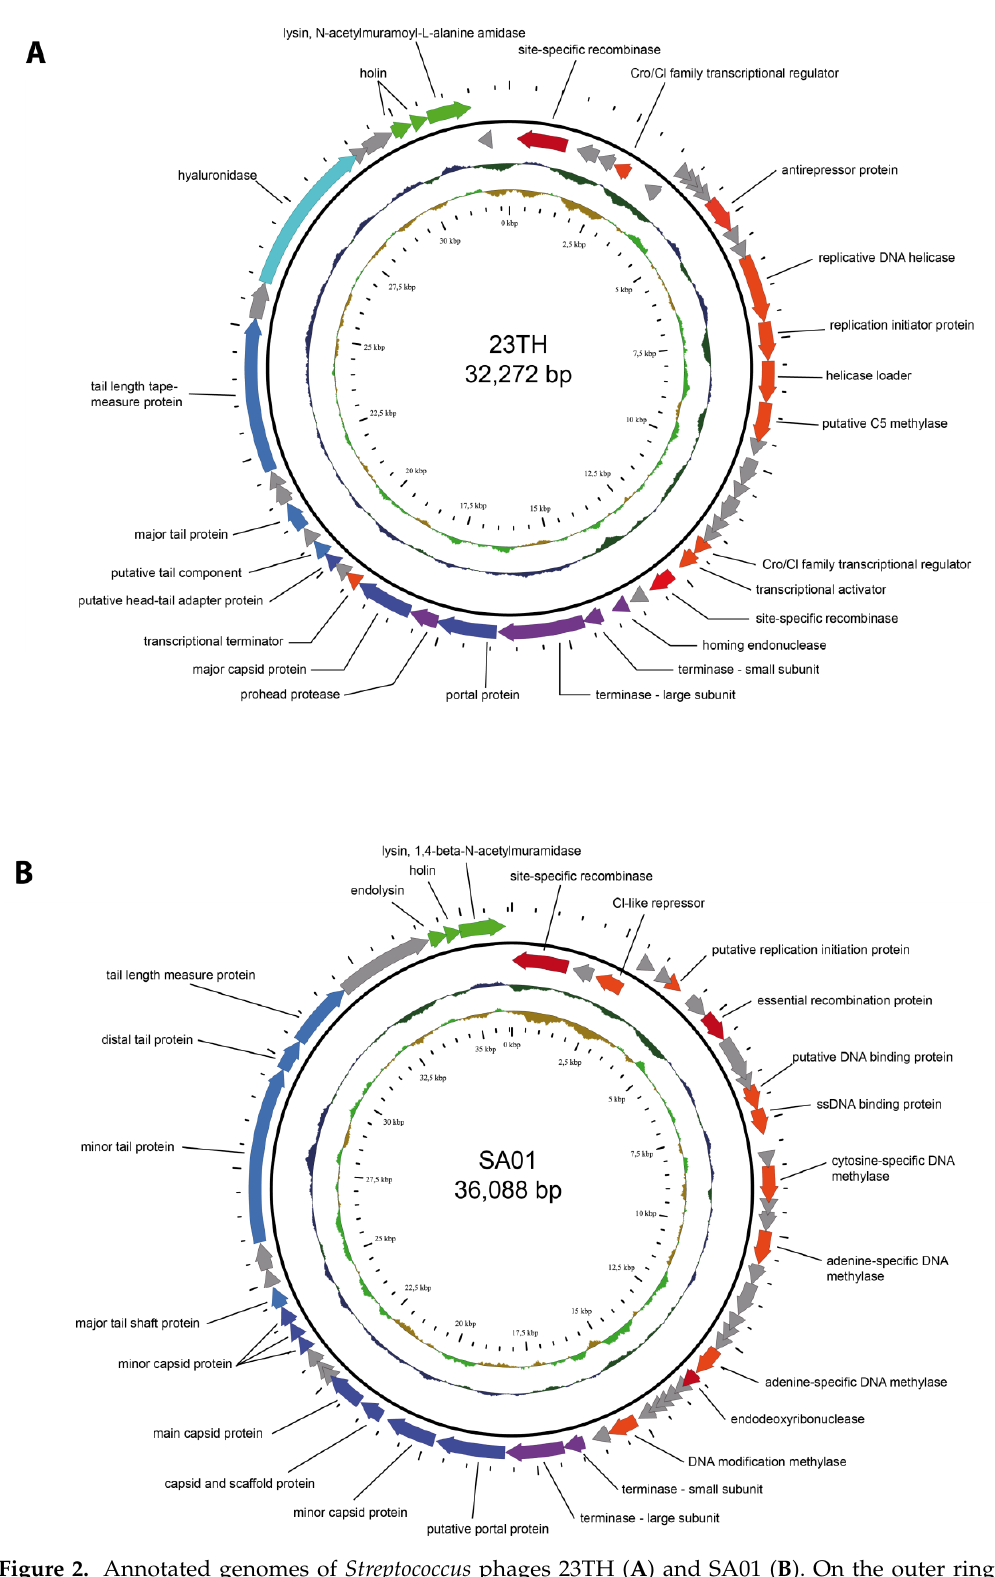
Figure 2. Annotated genomes of Streptococcus phages 23TH ( A ) and SA01 ( B ). On the outer ring, arrows represent ORFs: hypothetical proteins (grey), DNA replication, and regulation proteins (orange), proteins involved in recombination (red), packaging proteins (purple), phage structure proteins (blue), and lysis proteins (green). The middle ring represents GC content and the inner ring GC skew.